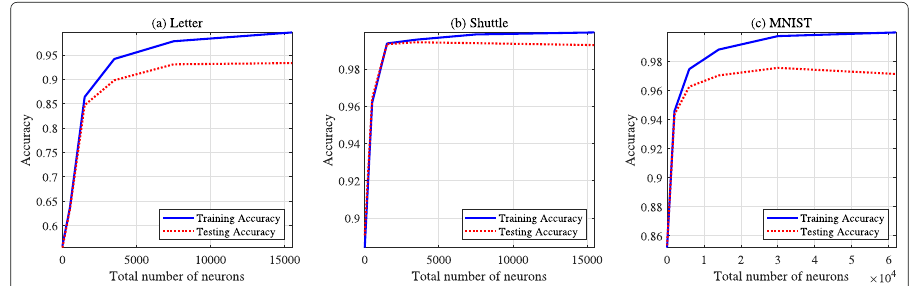
Fig. 1 Training and testing accuracy against size of one instance of HNF. Size of an L -layer HNF is represented by the number of random matrix-based nodes, counted as number of nodes in the first layer (2 n ( 1 ) ) is set according to Table 1 for each